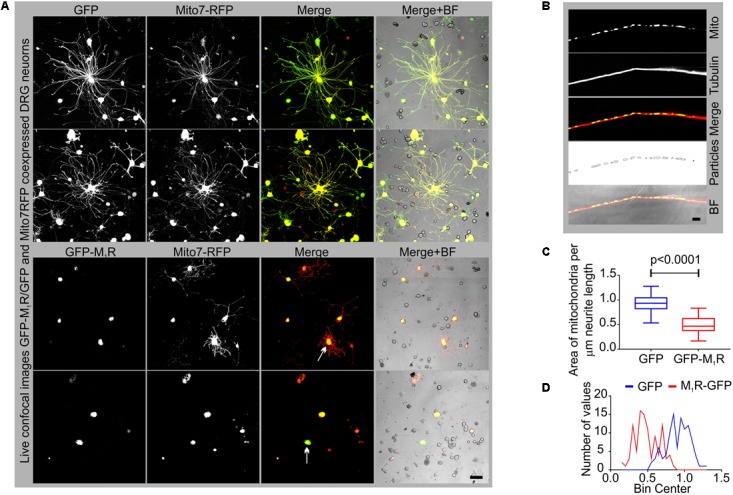
GFP-M1R over-expression in sensory neurons caused reduced mitochondrial abundance. (A) Representative images showing the signal of co-expression of GFP/GFP-M1R and mito7-RFP in DRG neurons. BF, bright field. (B) Immunofluorescence images showing mito7-RFP and β-tubulin III stained neurites. The 4th panel image showing tracing of the mitochondrial volume used for determining the amount of mitochondria per unit length of the neurites in GFP/GFP-M1R overexpressed DRG neurons. The tracing image was created using ImageJ particle counter plugin. Scale bar: 5 μm. (C) Whiskers box (min–max) showing amount of mitochondria in GFP/GFP-M1R transfected neurons. N = 101 from three independent experiments, p-value by t-test (unpaired). (D) Binning of the entire data set presented in (C).